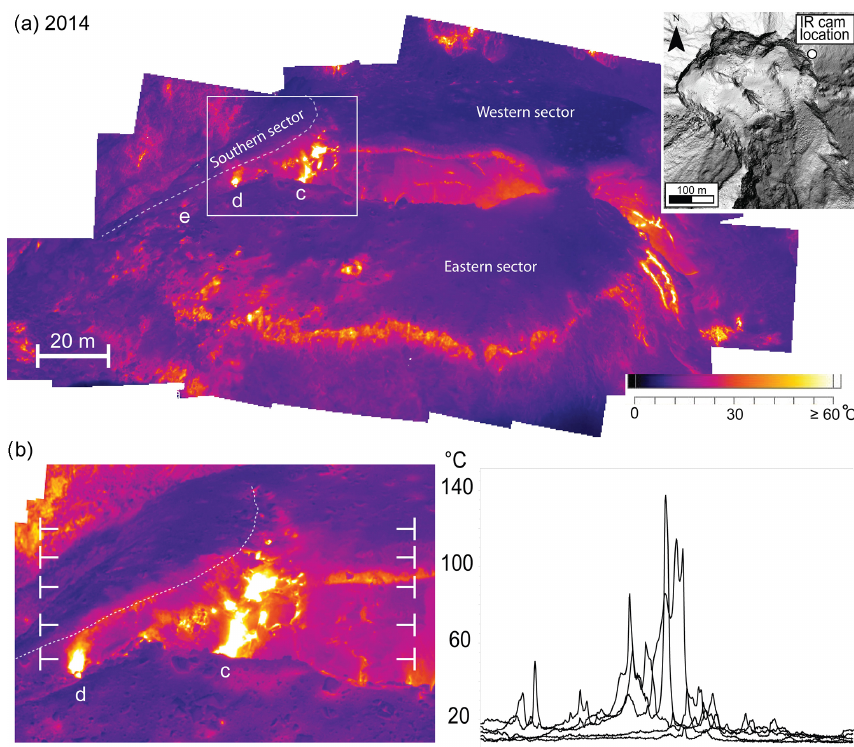
Figure 5. (a) Photomosaic of high-resolution thermal images taken from the eastern flank (inset) shows the variation of apparent thermal variation of the Merapi dome in 2014. (b) We find high temperatures around ≥ 140 ◦ C at the horseshoe-shaped structure and along the fracture area of c, d and e as identified by our drone camera. High thermal pixel value may indicate a hydrothermal fluid activity that can progressively alter and ultimately weaken the